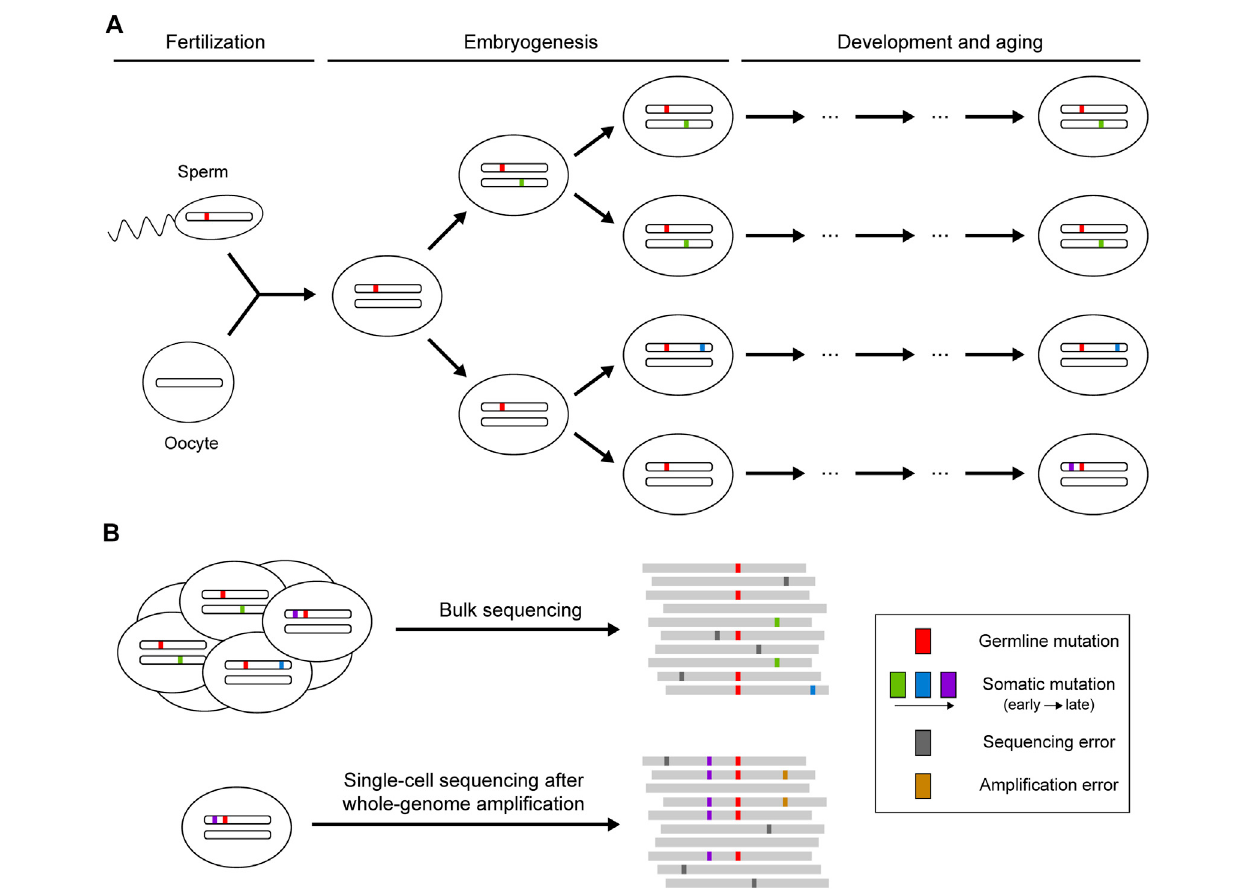
FIGURE 1 | Occurrence of somatic mutations and their identi fi cation in next-generation sequencing data. (A) Somatic mutations that occur postzygotically after fertilization. Mutations arising during embryogenesis or under clonal expansion (green and blue) are shared in a fraction of the cell population, whereas mutations accumulating during the aging process (purple) may only be present in a single cell. (B) Identi fi cation of somatic mutations using bulk or single-cell sequencing. Bulk sequencing is suitable for detecting somatic mutations shared across multiple cells, though mutations with low allele fractions are dif fi cult to distinguish from sequencing errors. Private somatic mutations can be detected with single-cell sequencing, but the whole-genome ampli fi cation before sequencing may introduce additional artifacts resulting from ampli fi cation errors.